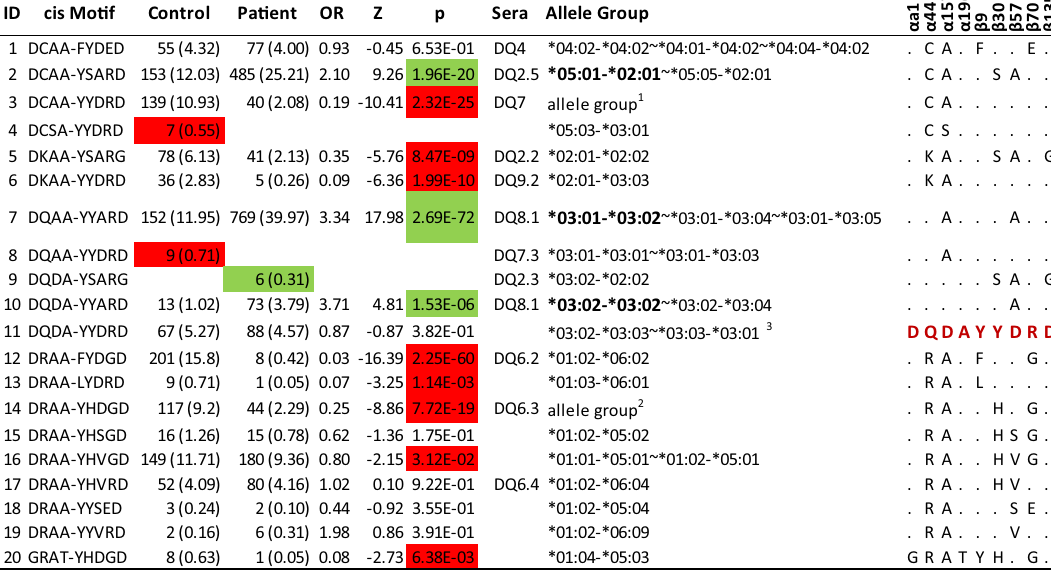
p = 7.87*10 −102 ). The next residue α157 took three possible amino acids (A, D, S); the first two, α157A/D, had significant resistance associations (OR = 0.40 and 0.68, p = 7.83*10 −89 and 0.034, respectively), while α157S was absent among patients but had seven allelic copies among controls with low risk DQ haplotypes. Among high-risk subjects, α157A/D were significantly associated with susceptibility to T1D (OR = 2.05 and 3.27, p = 1.27*10 −73 and 9.57*10 −8 , respectively), while the third residue, α157S, was absent. Again, T1D risk associations with α157A/D were significantly different between low- and high-risk subjects (exact Fisher’s p = 9.18*10 −97 and 4.93*10 −8 , respectively). The next residue, β9, had three amino acids associated with resistance (F, L, Y; OR = 0.22, 0.07 and 0.51, p = 9.44*10 −44 , 1.14*10 −3 and 5.25*10 −36 , respectively) among low-risk subjects. Among high-risk subjects, β9F and L were absent, while β9Y was associated with T1D risk (OR = 2.10, p = 1.84*10 −91 ), and the association was significantly different between high and low risk (exact Fisher’s p = 3.74*10 −66 ). Among low-risk subjects, resi- due β30 had two resistant amino acids β30H/Y (OR = 0.61 and 0.27, p = 2.09*10 −13 and 1.02*10 −71 , respectively), and β30S was not observed in such carriers. Among high-risk subjects, β30S/Y had significant associations with susceptibility to T1D (OR = 1.52 and 2.75, p = 1.85*10 −10 and 4.45*10 −71 , respectively), but β30H was not observed in these subjects. For amino acid β30Y, its association with T1D was significantly different between low- and high-risk subjects (Fisher’s exact test; p = 7.62*10 −106 ). The ninth residue, β70, had two amino acids significantly associated with resistance, G and R (OR = 0.33 and 0.46, p = 7.76*10 −19 and 1.84*10 −91 , respectively), and had one amino acid, β70E, with a neutral association (OR = 0.86, p = 0.34) among low-risk subjects. No high-risk subjects were found with β70E or G, while β70R was significantly associated with T1D (OR = 2.10, p = 1.84*10 −91 ), and its association was significantly different between high- and low-risk subjects (exact Fisher’s p = 2.19*10 −45 ). In summary, all these nine residues had highly significant associations with T1D among subjects with either low- or high-risk DQ haplotypes. Strikingly, the same amino acids could exhibit paradoxical associations between low- and high-risk subjects. Further, some of common amino acids in the high-risk group are absent from the low-risk group, and vice-versa. Note that some motifs listed in Table 2 had fewer than 10 observed copies, e.g., ID 13, 18, 19 and 20, and their associated p-values were not robust enough and should be taken as suggestive values. Motifs of nine residues account for DQ susceptibility and resistance to type 1 diabetes risks. Four alpha residues and five beta residues originated from transcription in cis and haplotypes of these nine amino acids are referred to as cis DQ motifs. In total, there were 25 unique DQ motifs: four susceptibility